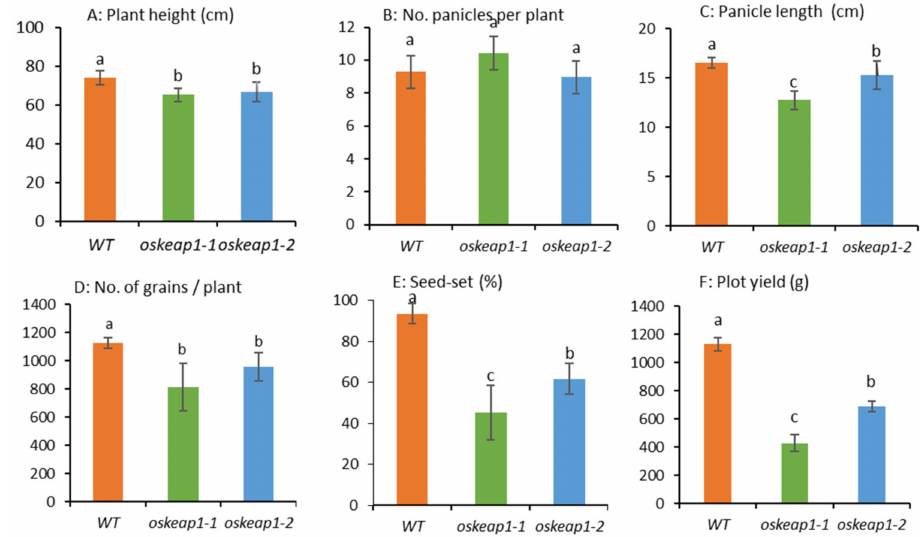
Figure 5. The agronomic and yield-related traits of rice wild-type cultivar Xidao #1 (WT) and its two oskeap1 mutants. Values are mean ± SD of 3 replicates. Di ff erent letters represent significance at the 0.05 level.